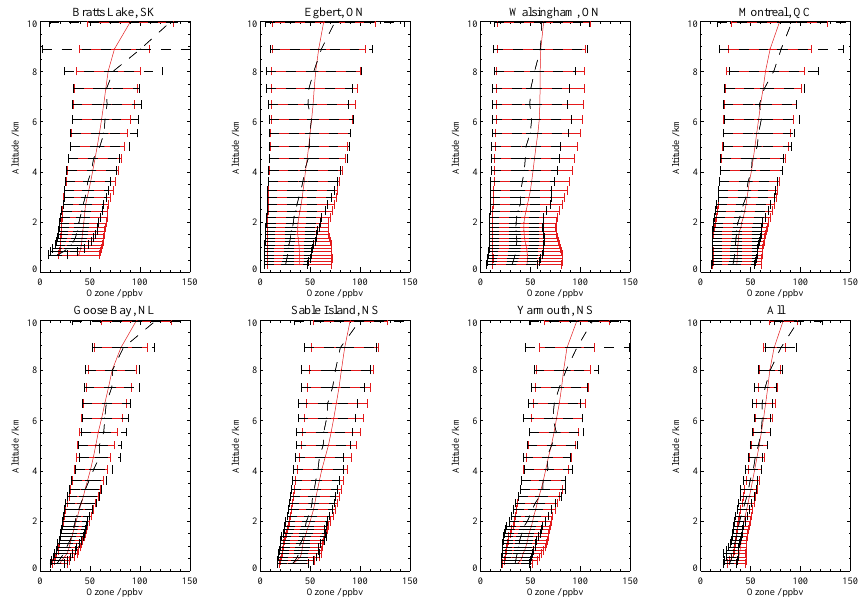
Fig. 3. Mean model and observed tropospheric ozone profiles over each of the ozonesonde launch sites listed in Table 1. Black dashed lines show the mean ozonesonde profile at each site and red solid lines show the mean spatially and temporally co-located GEOS-Chem ozone profile to each ozonesonde. Error bars show the 1- σ standard deviation. The bottom right plot is the mean ozone profile from all 153 ozonesondes launched throughout the